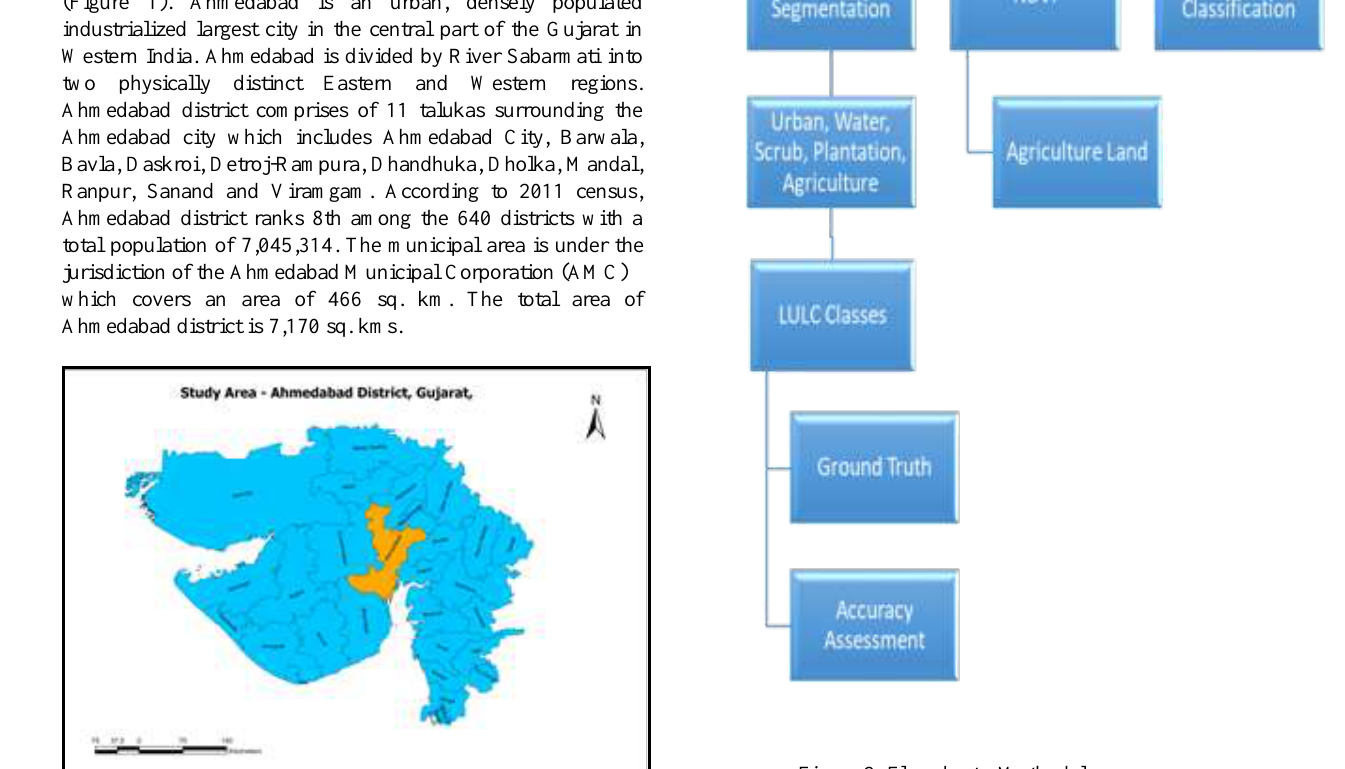
Figure 2. Flowchart -